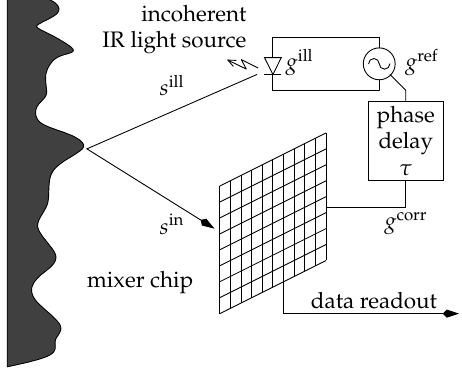
Figure 1. The time of flight (ToF) phase-measurement principle